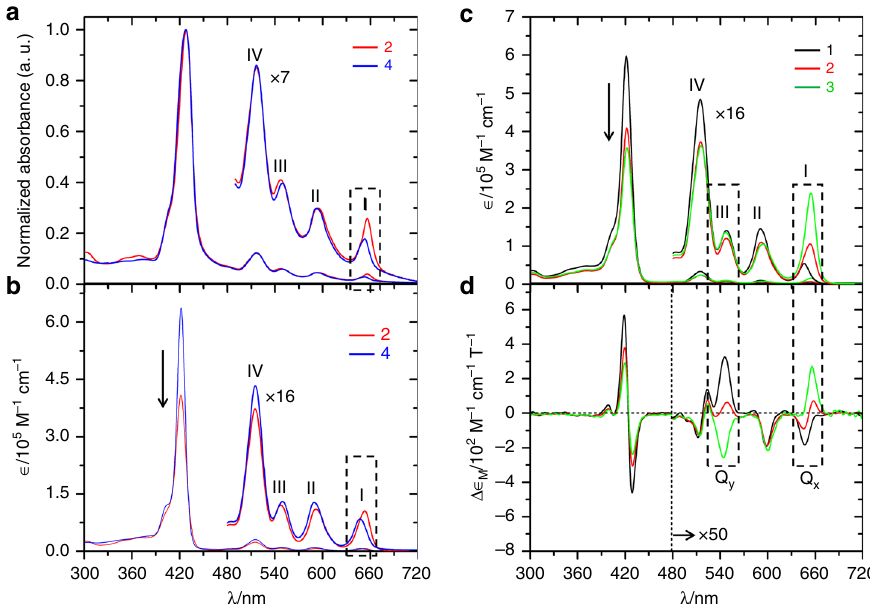
Fig. 3 Electronic properties of porphyrin unit. a , b Comparison of UV-Visible absorption spectra of compounds 2 and 4 in the solvent-free liquid state (normalised at Soret-band peak intensity) ( a ) and dichloromethane solution ( b ). The four Q-bands are designated as I – IV . c , d , UV-Visible absorption ( c ) and the corresponding MCD spectra ( d ) of compounds 1 – 3 recorded in dichloromethane. The systematic changes in the Q-bands are shown at bands I and III . Solutions having concentrations 1.2×10 − 6 M and 2×10 − 5 M were used for recording the Soret and Q-band spectra, respectively, in